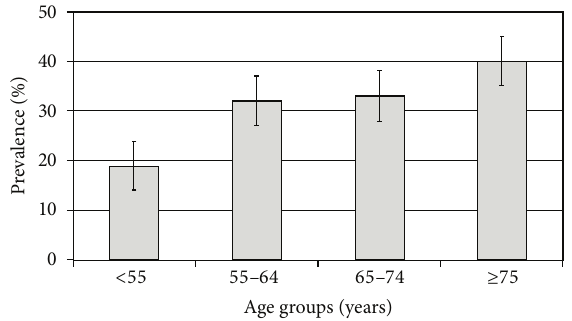
Figure 2: Prevalence of white coat hypertension in CKD patients stratified by age [26]. 𝑃 = 0.001 for